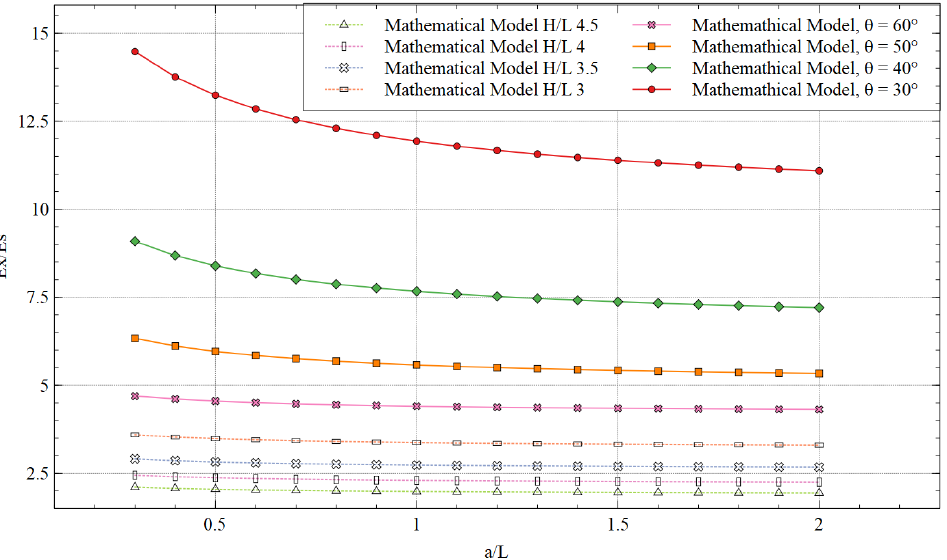
Figure 18. Young’s modulus in the x-direction for different values of H/L and re-entrant angle.